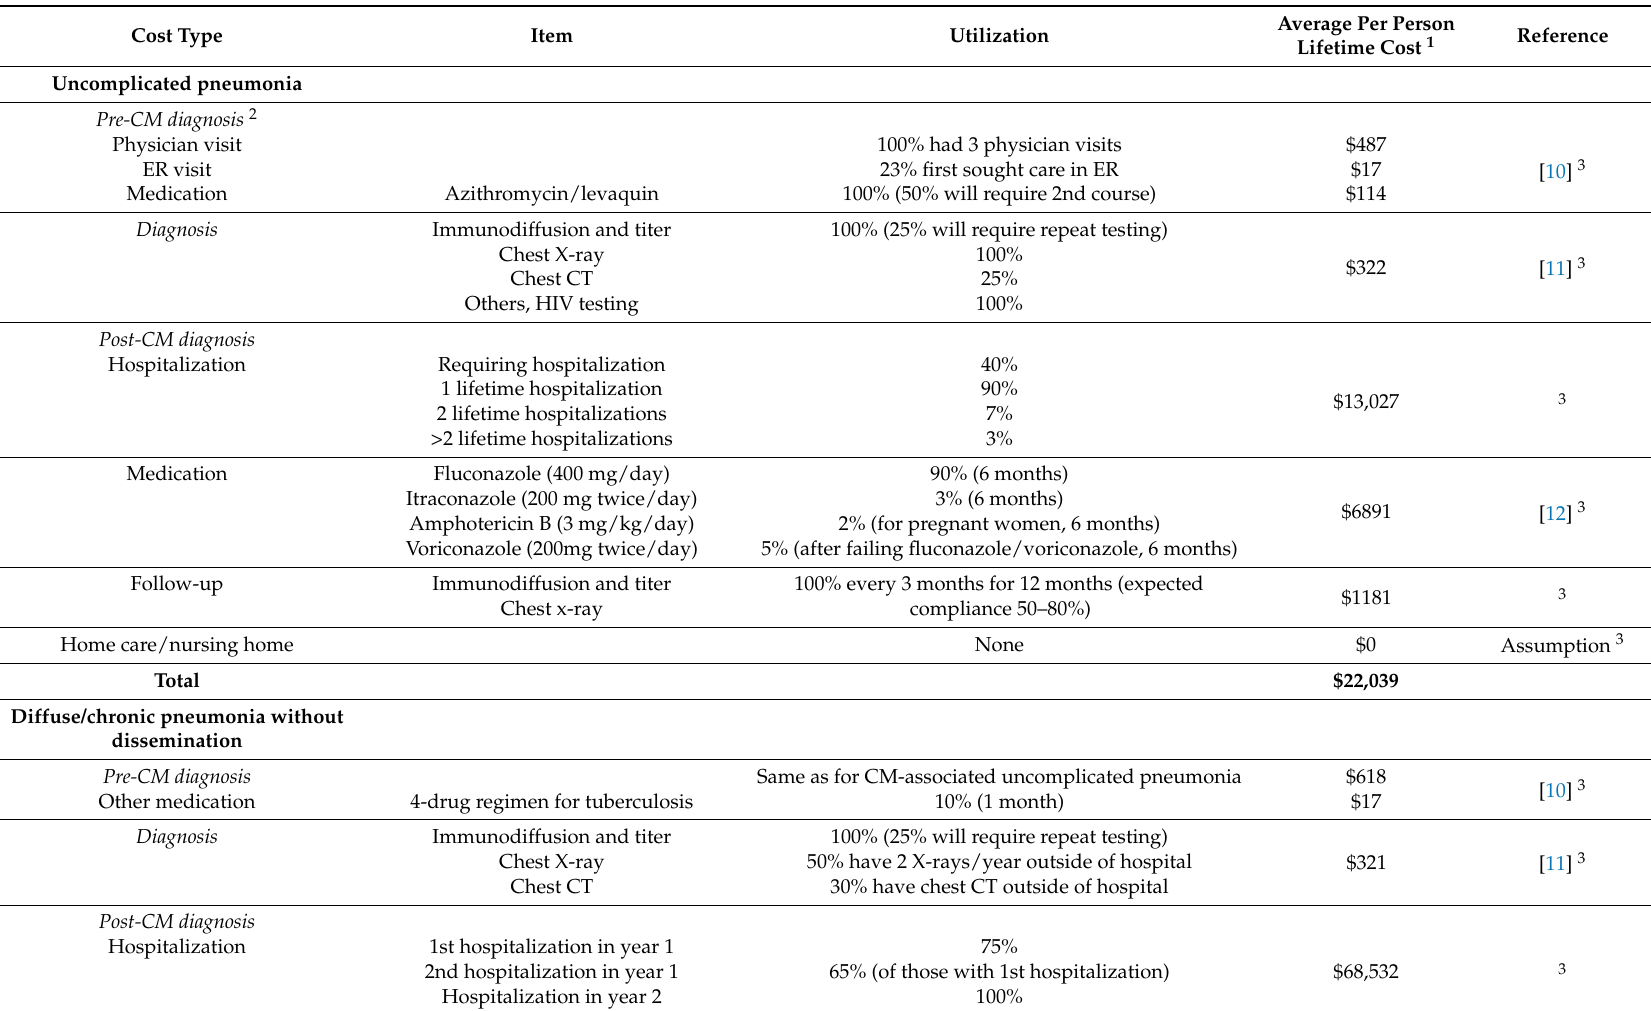
Table 1. Estimated direct lifetime costs per person, stratified by types of costs and coccidioidomycosis (CM) disease manifestation in